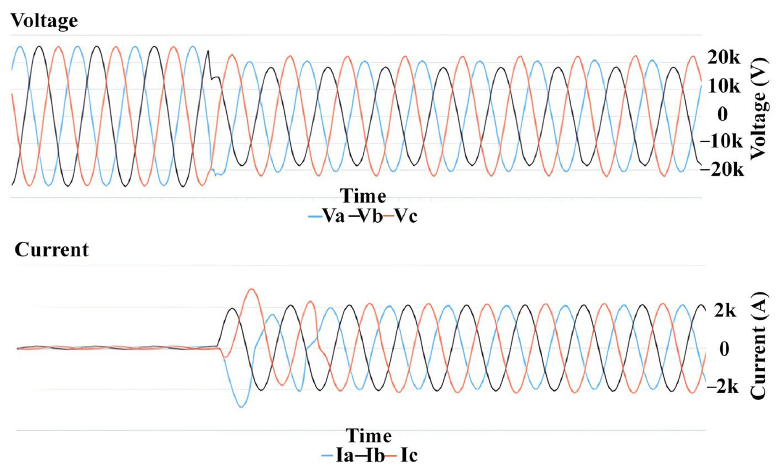
Figure A6. Current and voltage waveform recorded by PQ analyzer during the voltage sag for event 6.